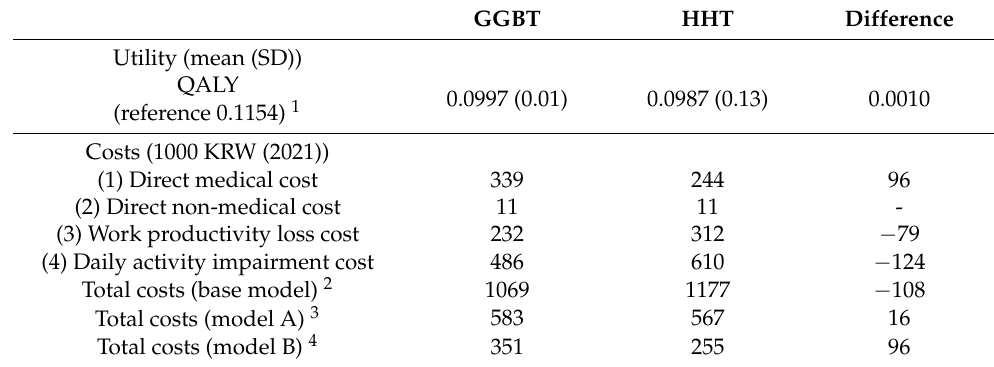
Table 3. The results of quality-adjusted life years and costs for 6